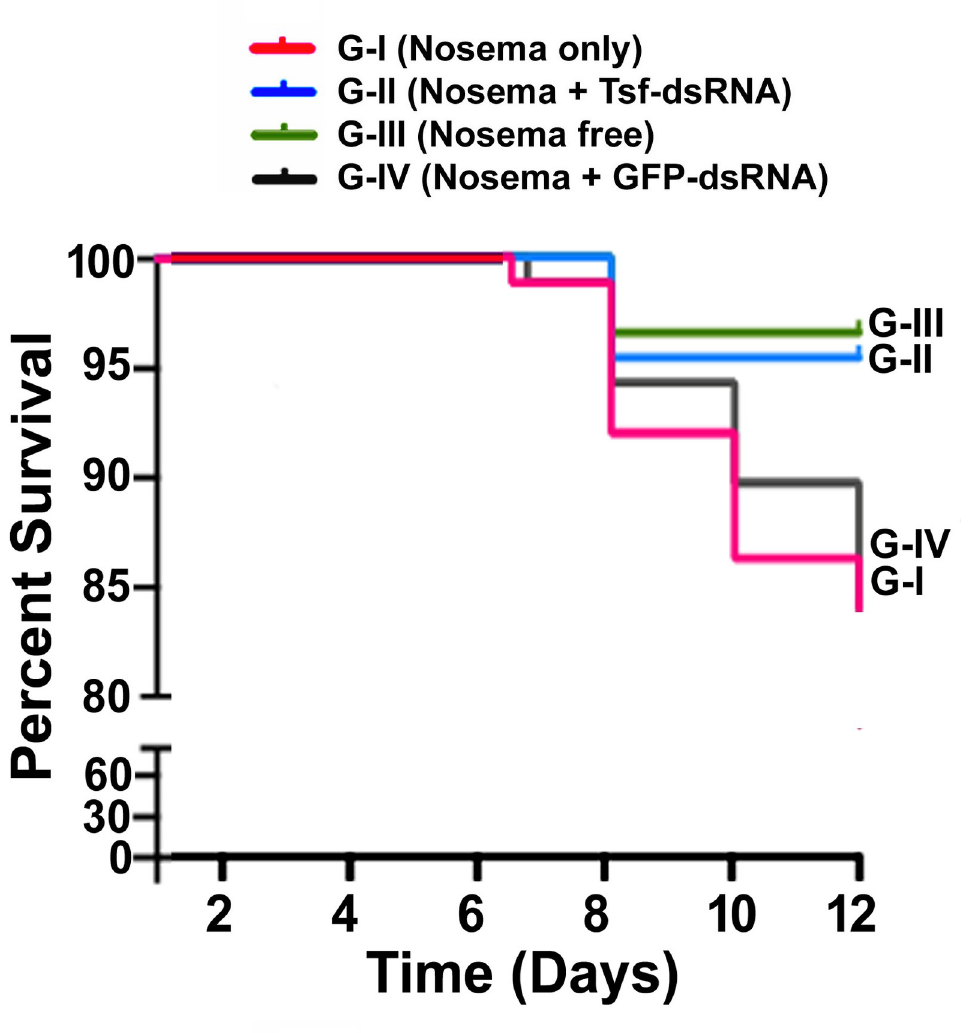
Fig 11. Kaplan–Meier survival curves for the three experimental groups (N = 90 bees/group). Data represent percentage of survival for the four groups over 12 days of experimental observation. Group I: Nosema -infected bees (infected/untreated); Group II: Nosema -infected bees + AmTsf -dsRNA treatment (infected/treated); Group III: Healthy bees (uninfected/untreated) and Group IV: Nosema-infected bees + GFP-dsRNA. Knockdown of the honey bee transferrin gene reduced the incidence of death ( p < 0.05 by Wilcoxon test < p = 0 . 0041 > and Log-rank test < P = 0.0033 > ).